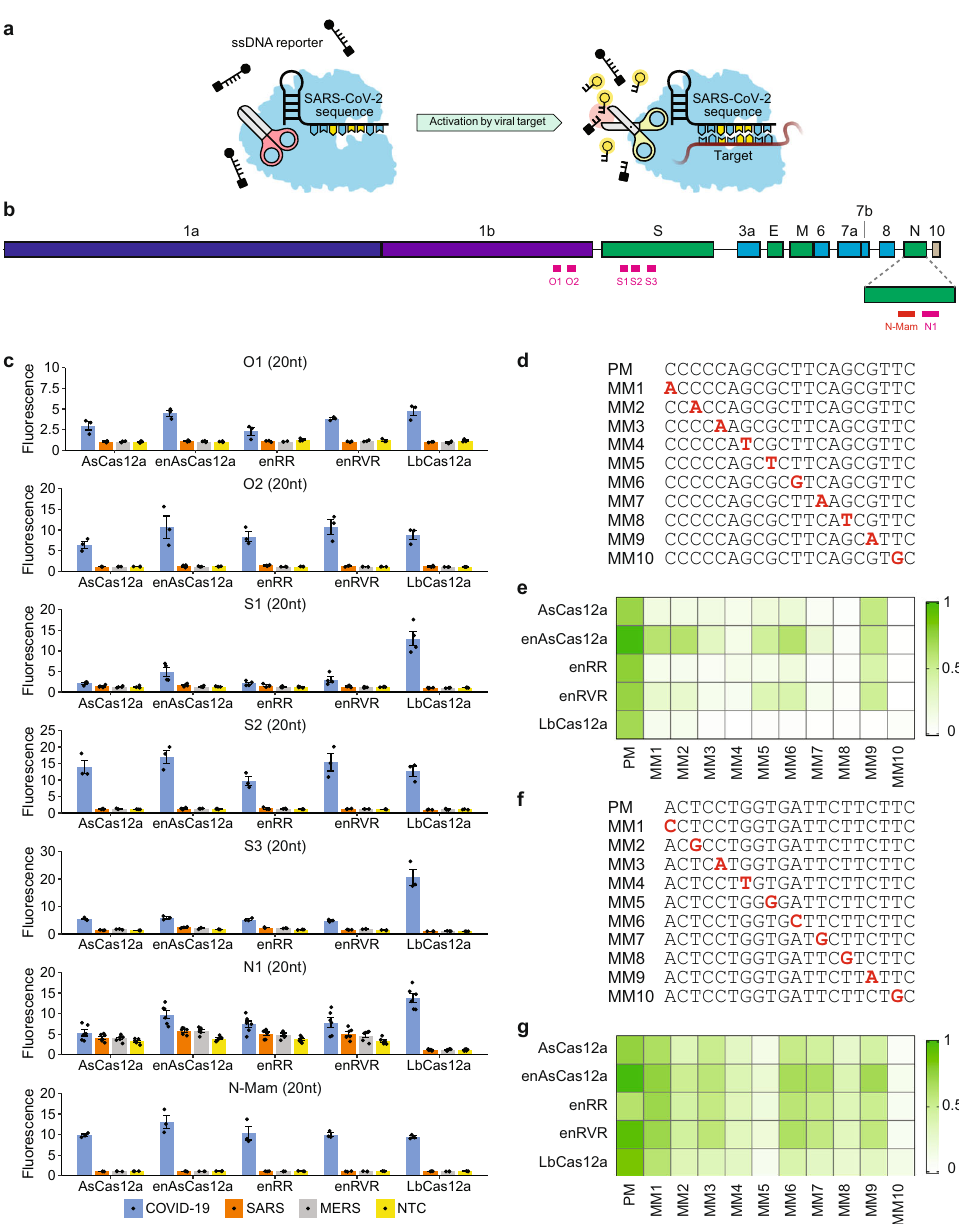
Fig. 1 Evaluation of different Cas12a-gRNA combinations at room temperature (24 °C). a Schematic of a fl uorescence trans -cleavage assay. Here, the reporter comprises a fl uorophore linked to a quencher by a short piece of ssDNA. The gRNA is programmed to recognize a particular locus of the SARS- CoV-2 genome. In the absence of the virus, the reporter molecule is intact and thus no fl uorescence is observed. However, when the virus is present, the Cas12a RNP will bind to and cleave its programmed target, become hyperactivated, and cut the linker between the fl uorophore and quencher, thereby generating a fl uorescence signal. b Organization of the SARS-CoV-2 genome. Genes encoding structural proteins are indicated by green boxes, while genes encoding accessory proteins are indicated by cyan boxes. Although ORF10 is annotated in the genome, there is currently no evidence of its expression 71 . The locations of the new gRNAs are shown by pink bars below the genes, while the N-Mam locus is shown by a red bar. c Fluorescence measurements using a microplate reader after 30 min of cleavage reaction. 1E11 copies of the relevant DNA target were present in a 50 μ l reaction. All readings were normalized to the no template control (NTC) at the start of the experiment. The N1 gRNA gave an unexpected result, whereby it triggered the collateral activity of AsCas12a and its variants without a template. Data represent mean ± s.e.m. ( n = 3 [N-Mam, O1, O2, S2, S3], 4 [S1], or 6 [N1] biological replicates). d Sequences of perfect matched (PM) or mismatched (MM) spacers targeting the N-Mam locus. Each mismatched position is indicated by a bold red letter. e Heatmap showing the tolerance of various Cas12a enzymes to mismatched N-Mam gRNAs. The fl uorescence readings are scaled between 0 and 1, where 1 is the highest measurement obtained and 0 is the background signal for NTC at the start of the experiment. f Sequences of perfect matched (PM) or mismatched (MM) spacers targeting the S2 locus. Each mismatched position is indicated by a bold red letter. g Heatmap showing the tolerance of various Cas12a enzymes to mismatched S2 gRNAs. The fl uorescence readings are scaled between 0 and 1, where 1 is the highest measurement obtained and 0 is the background signal for NTC at the start of the experiment. Source data are available in the Source Data fi le.